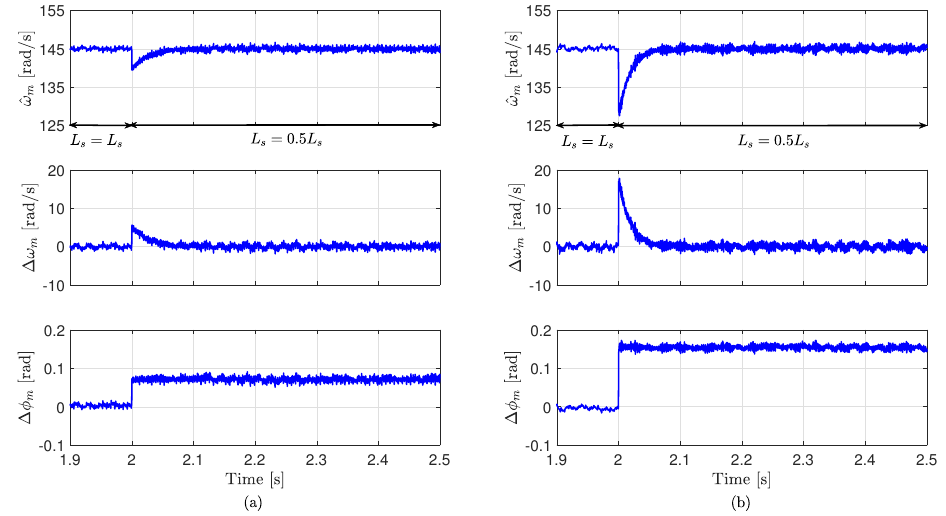
Figure 8. Experimental results at variations of the DFIG stator inductance L s : ( a ) LPS-MRAO, and ( b ) traditional